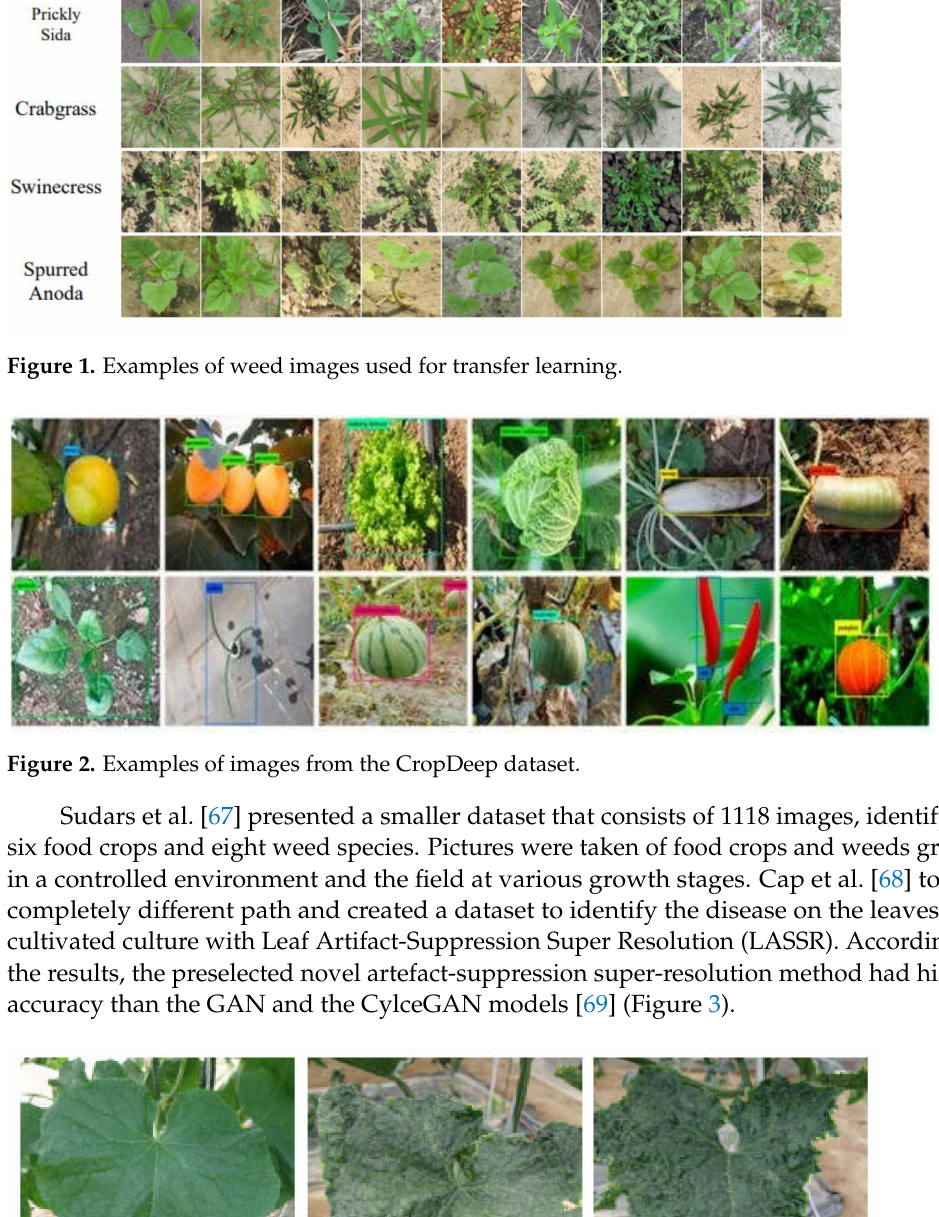
Figure 1. Examples of weed images used for transfer learning.